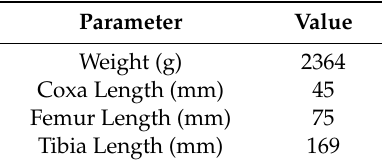
Table 3. Simulation parameters setting.